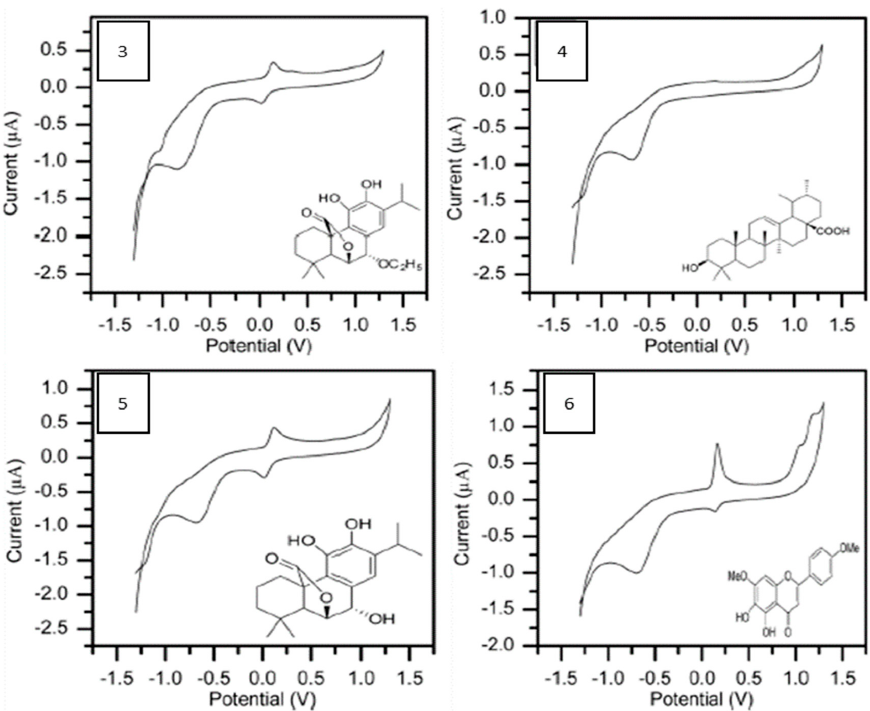
Figure 3. Cyclic voltammograms of isolated compounds. The voltammograms were recorded at 50 mV/s (from − 1300 to 1300 mV) for 1 mg/L of each compound in phosphate buffer (pH